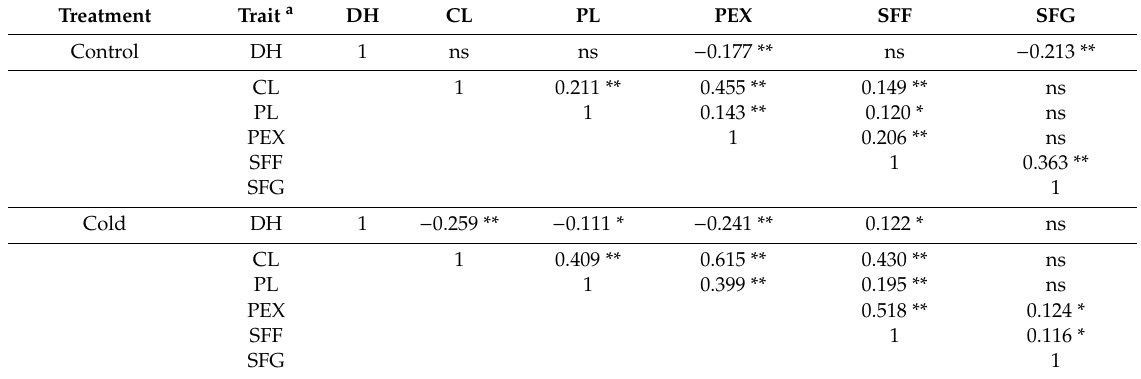
Table 3. Correlation coe ffi cients among major agronomic traits and spikelet fertility of the RIL population in the control and cold treatment.